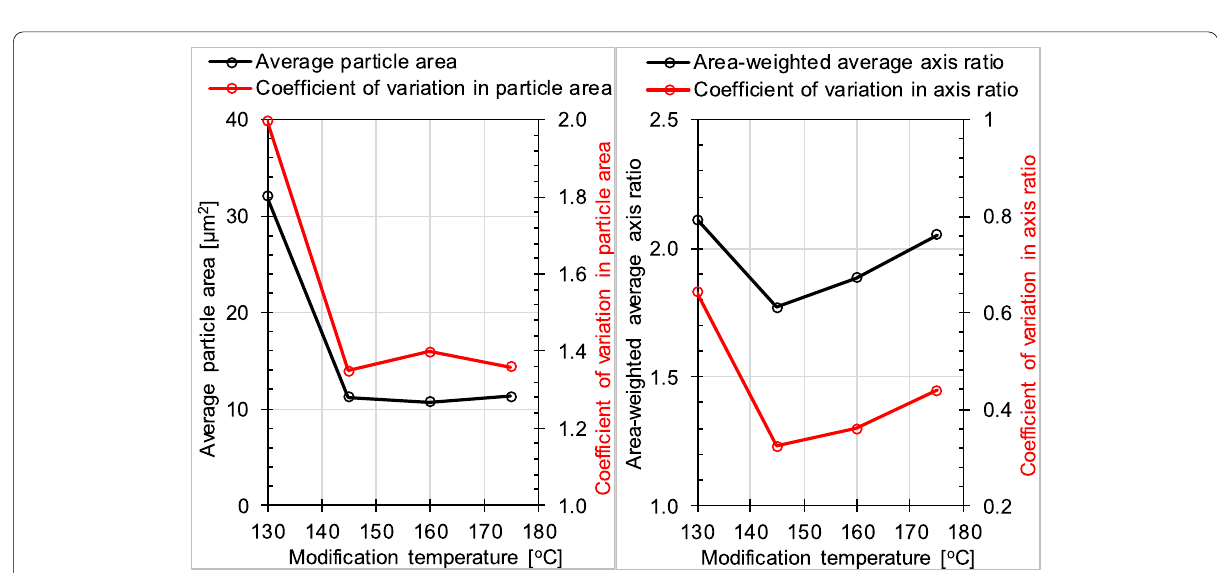
Fig. 9 Influence of modification temperature on the particle area and axis ratio in the